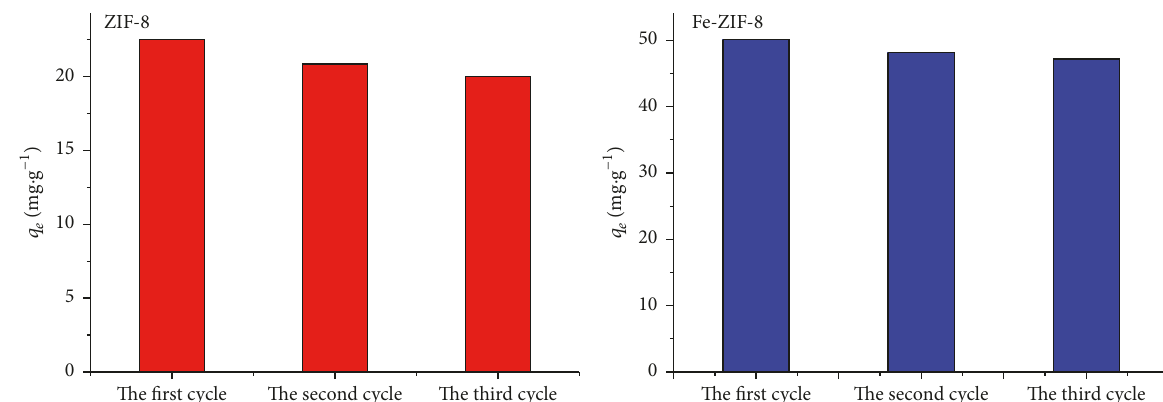
Figure 13: Effect of regeneration cycles of ZIF-8 and Fe-ZIF-8 adsorbents on the adsorption of RDB ( 𝑉 adsorbent/ 𝑉 = 0.05 g/125mL; shaking time = 10 hours). RDB